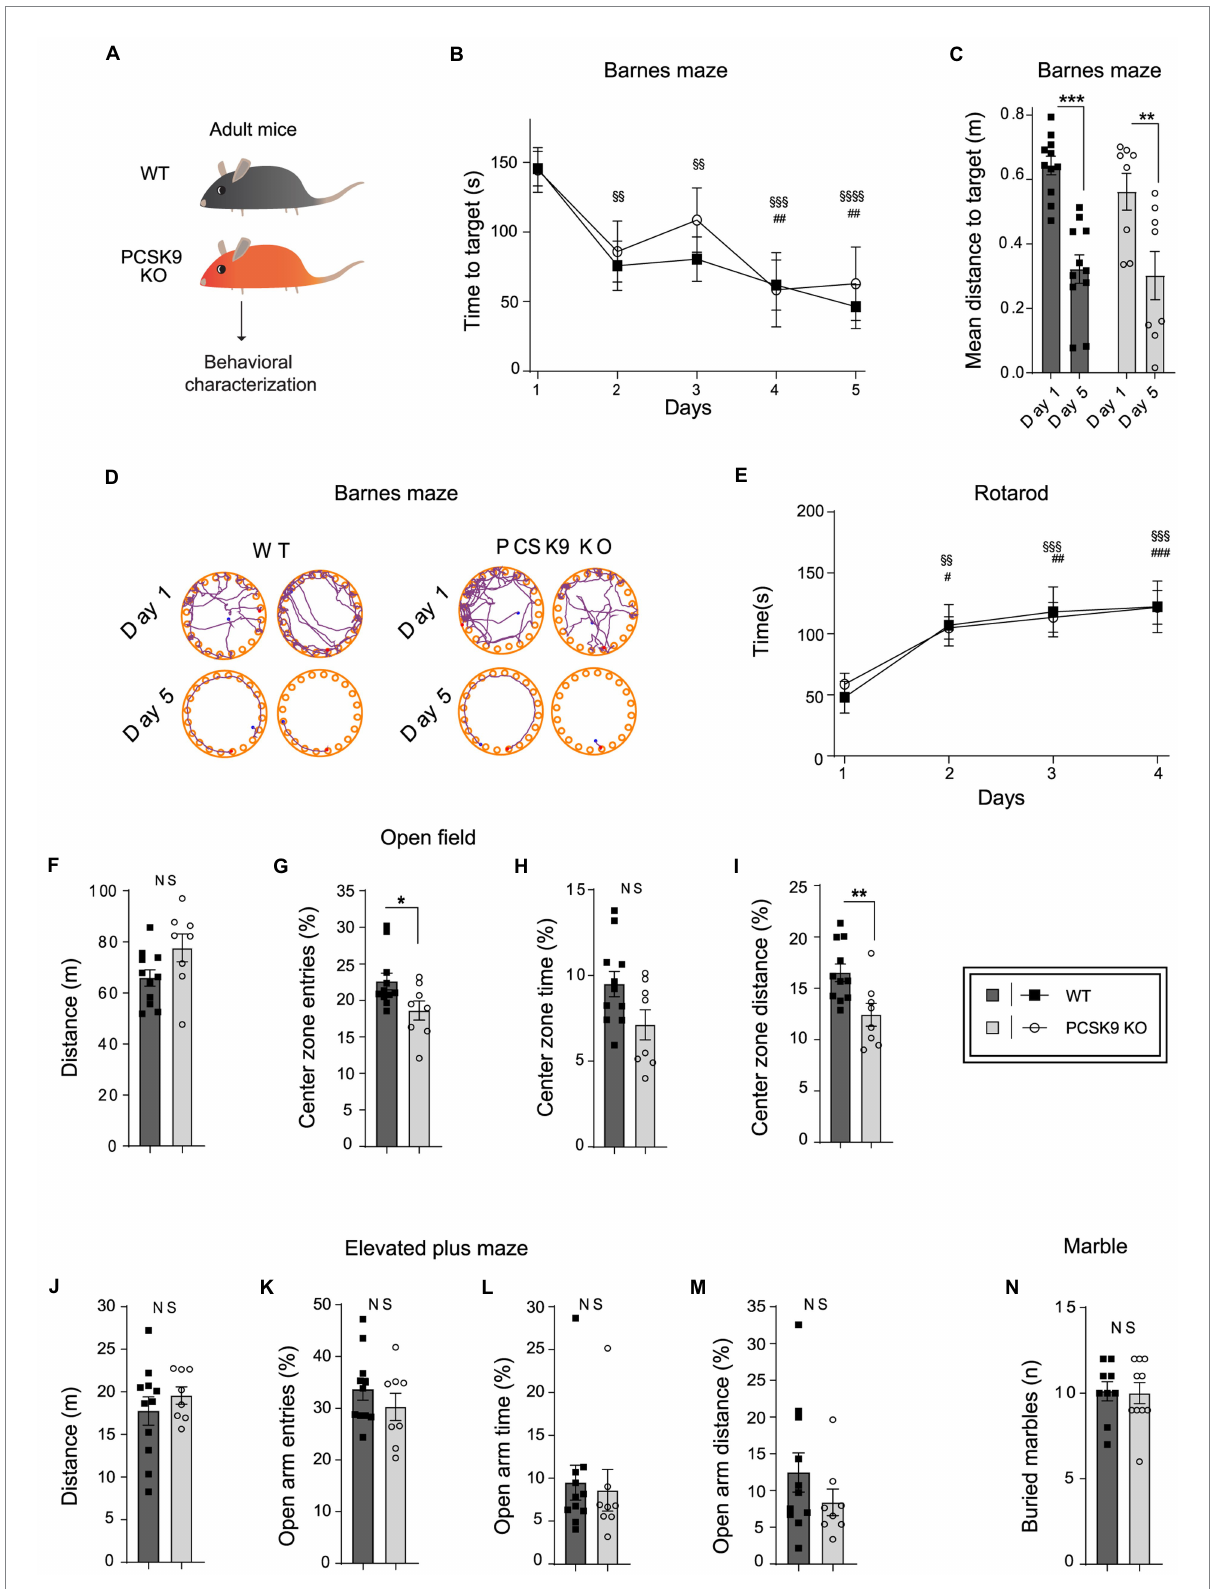
FIGURE 5 Behavioral characterization of PCSK9 KO mice. (A) Schematic representation of the experiment. (B–D) Barnes maze. Time to reach target (B) . Mean distance to target (C) . Representative examples of search patterns at Day 1 and Day 5 (D) ( N = 11 WT and 8 KO mice per group). (E)